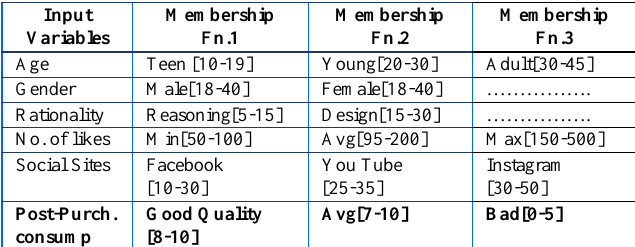
Table 1. Input & Membership functions with Ranges